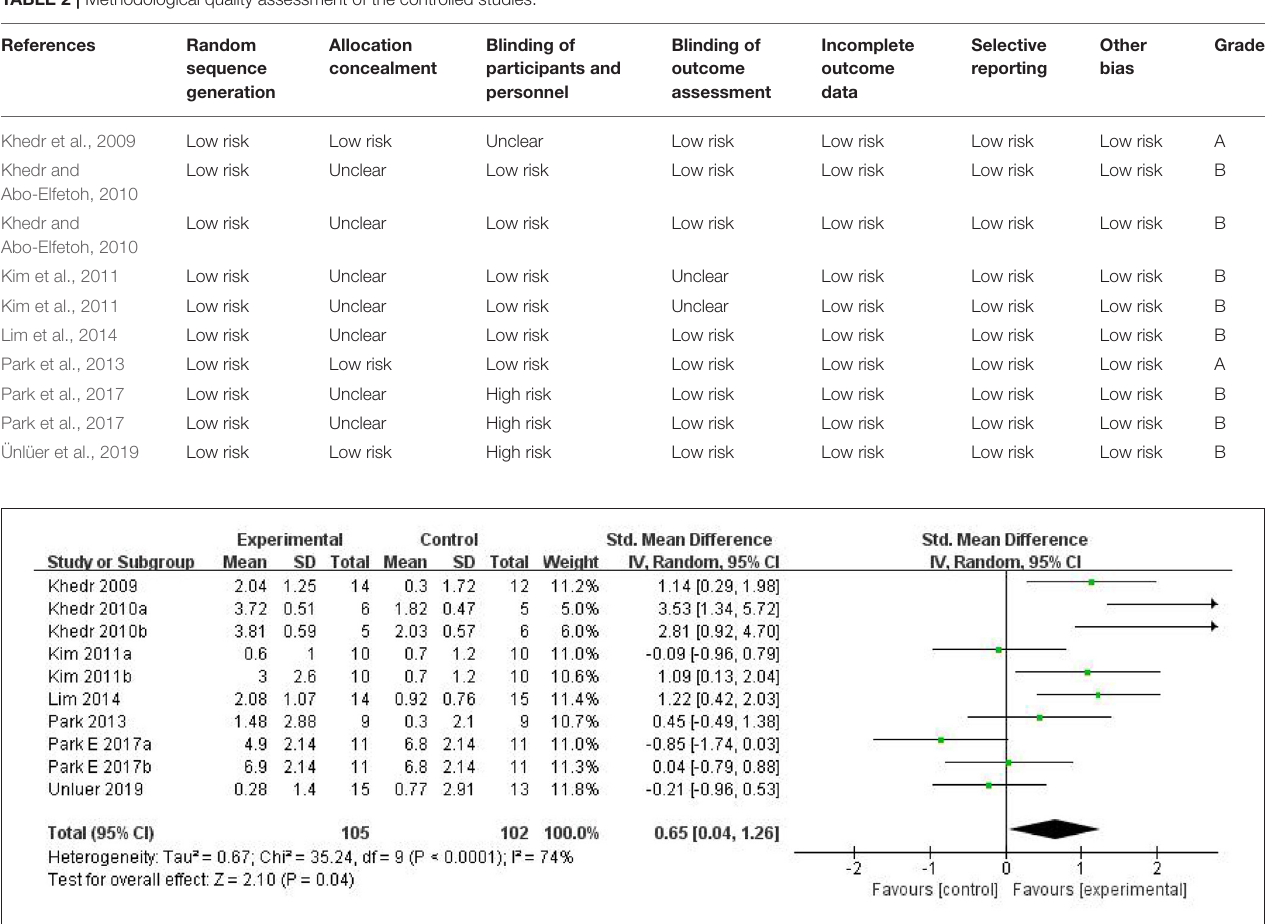
TABLE 2 | Methodological quality assessment of the controlled studies.